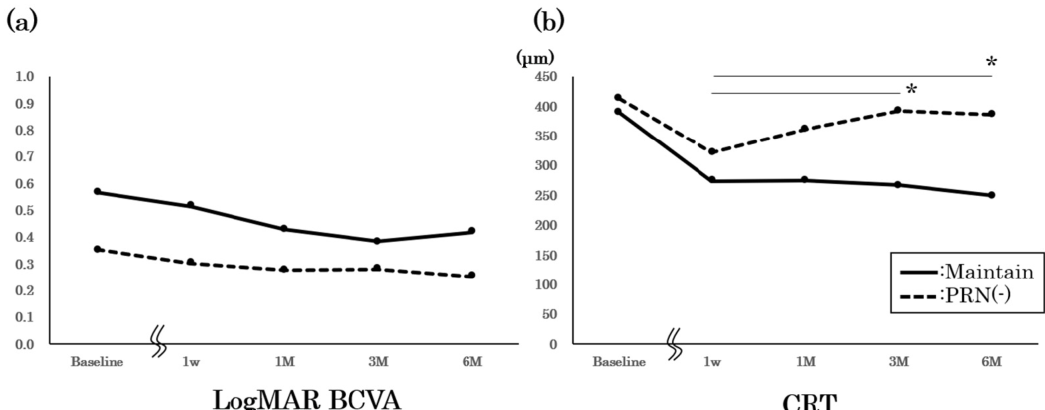
Figure 4. BCVA and CRT changes after the loading injections in the maintained and PRN [-] groups. Six-month changes after the loading injections for Log MAR BCVA ( a ) and CRT ( b ). BCVA: best- corrected visual acuity; CRT: central retina thickness; PRN: pro re nata. *: p < 0.05, repeated